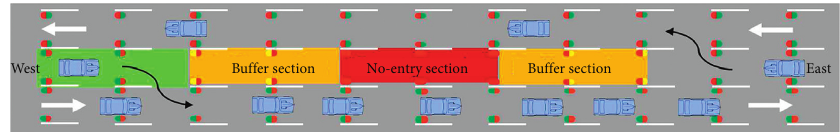
Figure 4: Configuration of ending conflict